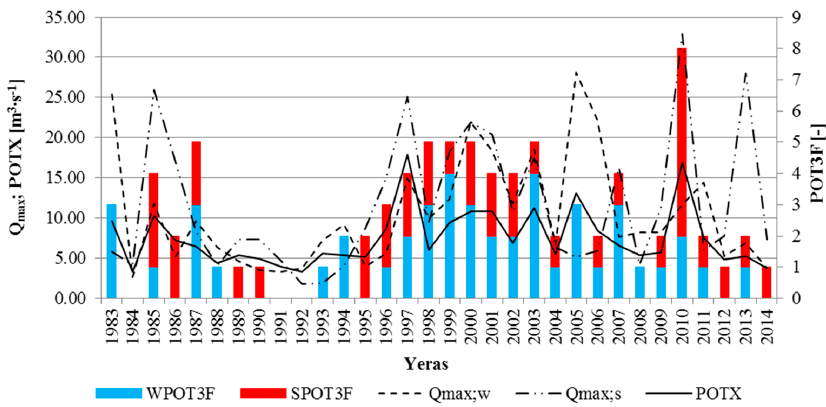
Figure 3. Q max;w , Q max;s , POTX, WPOT3F, SPOT3F and POT3F metrics for the catchment of the Rudawa at Balice cross ‐ section.